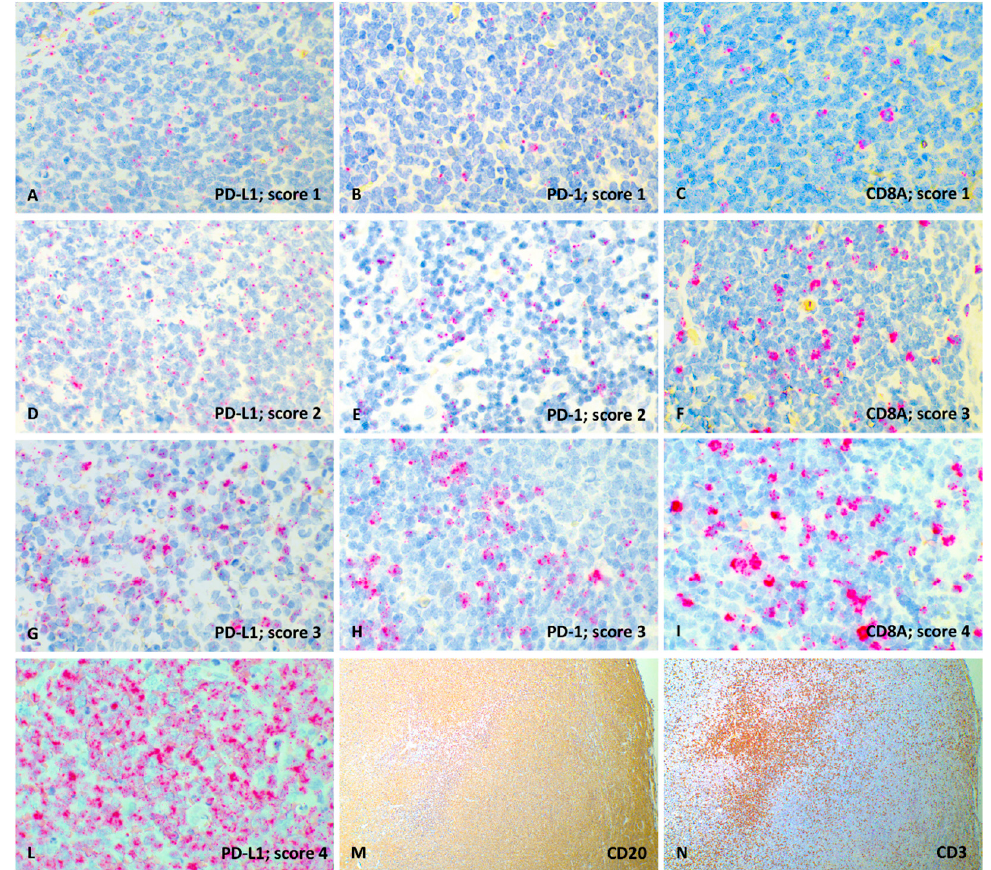
Figure 2. Representative images of PD-L1, PD-1 and CD8A RNAscope semi-quantitative evaluation (60x magnification) and CD20, CD3 immunohistochemical expression (4x magnification), lymph node, dog. ( A ) PD-L1 probe, score 1; ( B ) PD-1 probe, score 1; ( C ) CD8A probe, score 1; ( D ) PD-L1 probe, score 2; ( E ) PD-1 probe, score 2; ( F ) CD8A probe, score 3; ( G ) PD-L1 probe, score 3; ( H ) PD-1 probe, score 3; ( I ) CD8A probe, score 4; ( L ) PD-L1 probe, score 4; ( M ) Diffuse and strong membranous labeling of neoplastic lymphocytes with anti-CD20 antibody (IHC); ( N ) Focal and strong cytoplasmatic labeling of TIL with anti-CD3 antibody (IHC).